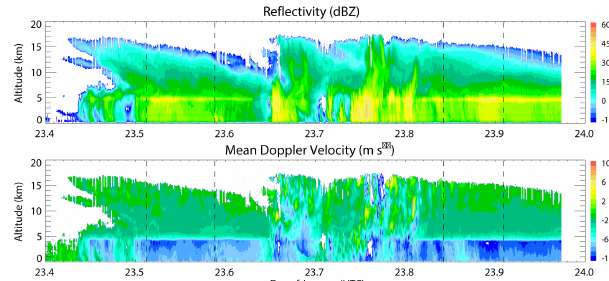
Figure 8. Equivalent radar reflectivity ( Z e ) and mean Doppler ve- locity curtain measured by the S-band profiler on 23 January 2006. Dashed lines indicate duration of two stratiform rain periods defined as described in text.